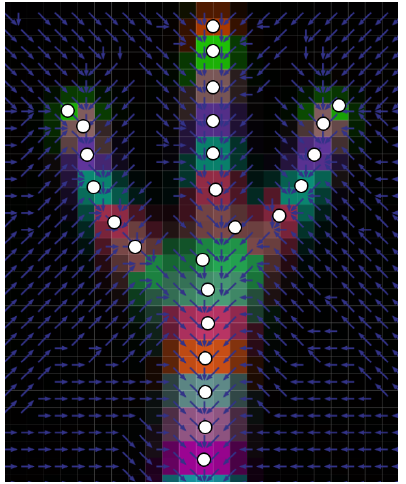
Figure 4. Dijkstra’s algorithm on a 2D three-point tree, using density-scaled distance function, and segmented by Euclidean path distance every two element widths. Brightness is pseudodensity. White points are the density-weighted centroids of each contiguous segment, which form the nodes of the Branch Structure